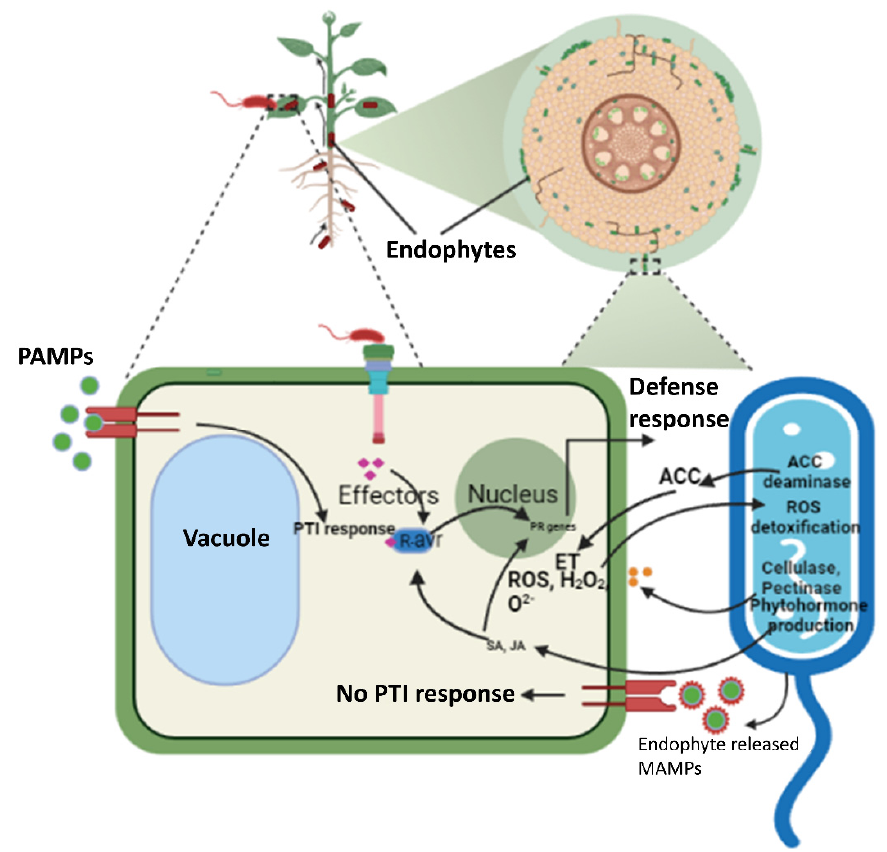
Figure 1. Host plant and endophyte crosstalk. The colonization of endophytes and their interaction with the host plant depends on the type of endophytes. Bacterial endophytes mostly make their entry through apertures formed either through the emergence of lateral roots or the zones of elongation. Fungal endophytes can either be transmitted vertically, i.e., transmission from maternal plants to the progeny seeds, or through their entry as fungal spores through herbivory or insects. Some endophytes also release cell wall–degrading enzymes to make their entry possible. Since these endophytes have specific MAMps, they are not recognized by the host plant PRRs. Endophytes help the plant in stress responses by producing phytohormones and reactive oxygen species (ROS) detoxification. ACC, aminocyclopropane-1-carboxylic acid; ROS, reactive oxygen species; MAMPs, microbe-associated molecular patterns; PR, pathogenesi-related; ET, ethylene; SA, salicylic acid; JA, jasmonic acid; PAMPs, pathogen-associated molecular patterns; PTI, PAMP-triggered immunity; R -avr, resistance gene a virulence effector.